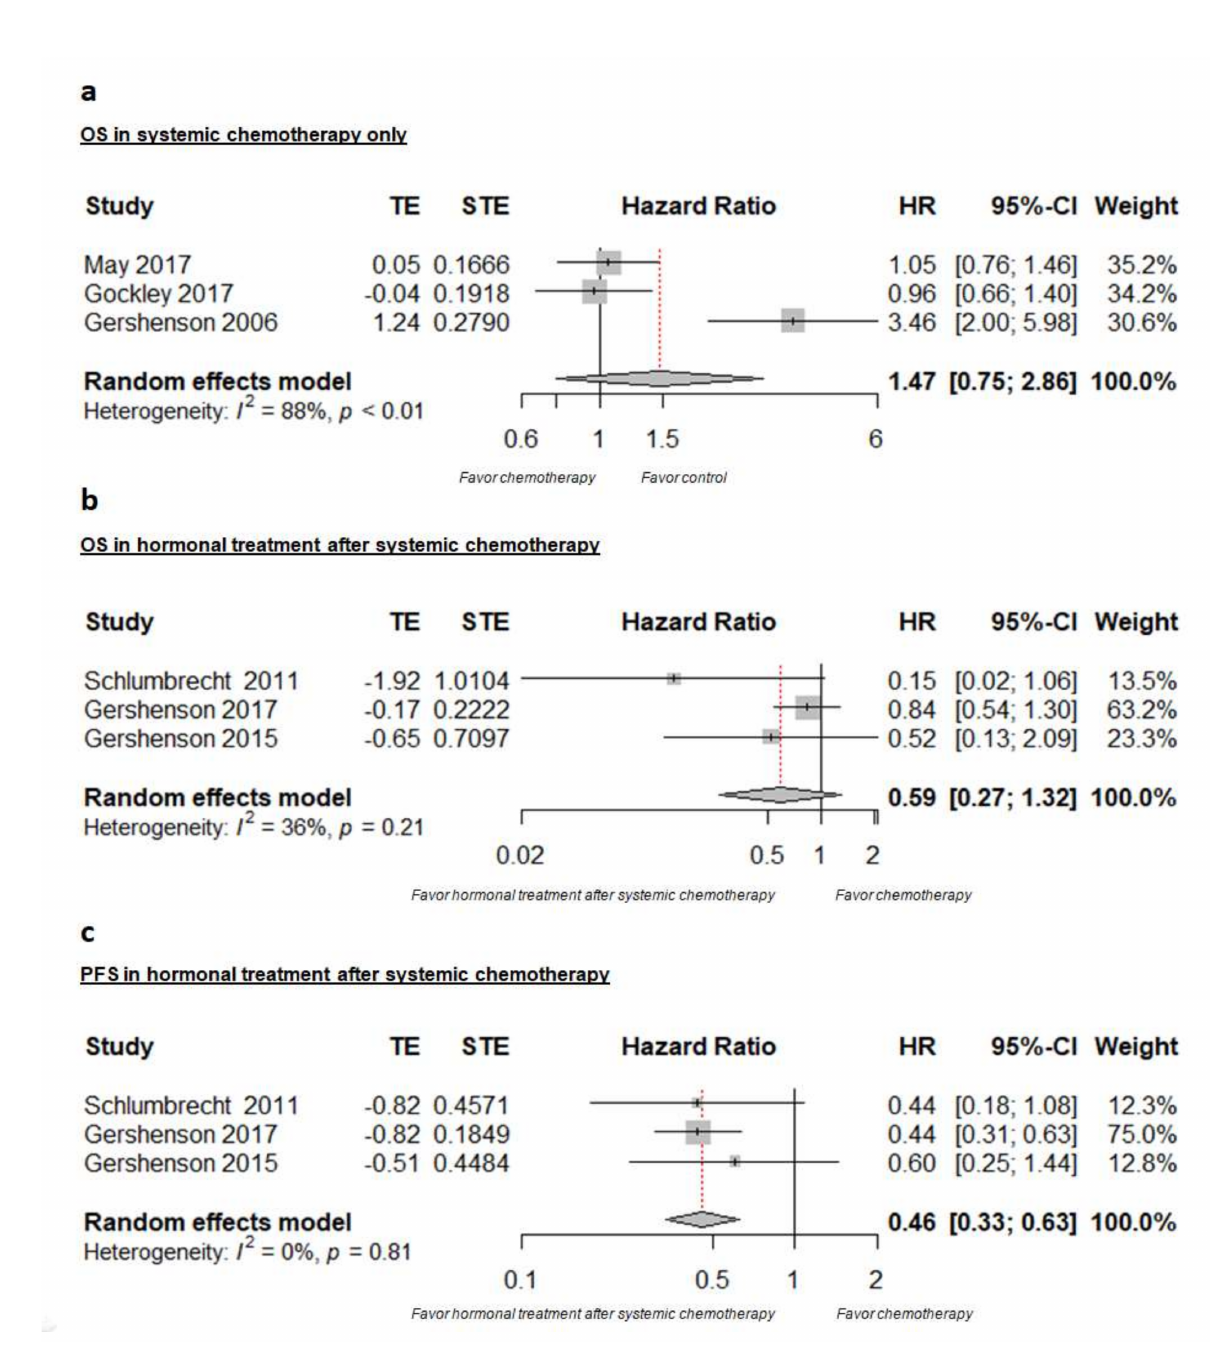
Figure 2. Meta-analysis for: ( a ) OS in patients with systemic chemotherapy alone, ( b ) for OS and ( c ) PFS for patients treated with additional antihormonal maintenance treatment after completion of systemic